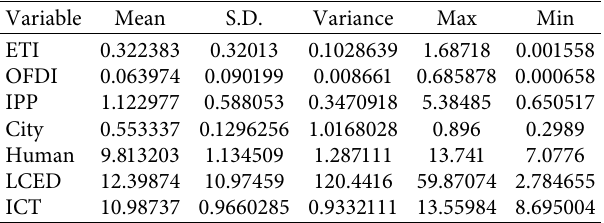
Table 1: Variable descriptive